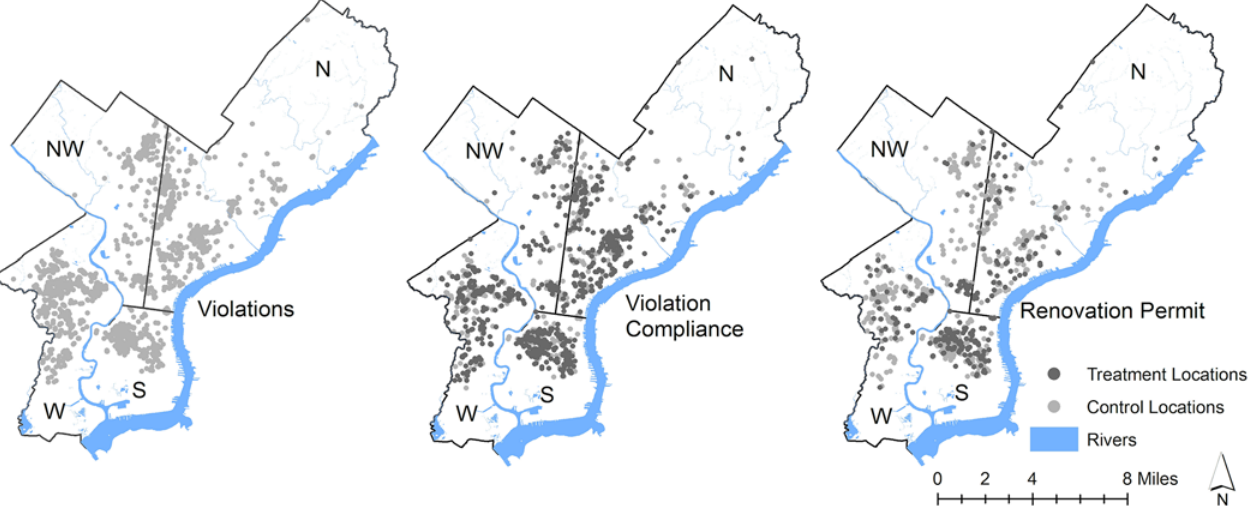
Fig 3. Map of Doors and Windows Ordinance violations, and treatment and control locations for violation compliance and renovation permits in Philadelphia, PA. Data source: Philadelphia Department of Licensing and Inspection (2013) North (N), Northwest (NW), South (S) and West (W) sections are